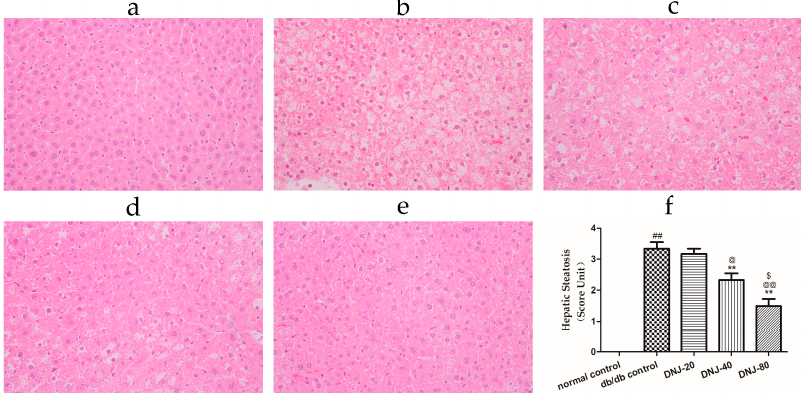
Figure 4. Effect of DNJ on hepatic pathological changes. Histological observation of the hematoxylin- eosin (H & E) sections (original magnification ×200). Macrovesicular steatosis was observed in the livers of db / db mice. ( a ) normal control; ( b ) db / db control; ( c ) DNJ-20; ( d ) DNJ-40; and ( e ) DNJ-80; additionally, quantification of hepatic steatosis ( f ) were carried out. ## p < 0.01 vs. normal control. ** p < 0.01 vs. db/db control, @ p < 0.05, @@ p < 0.01 vs. DNJ-20, $ p < 0.05 vs. DNJ-40 ( n = 6).